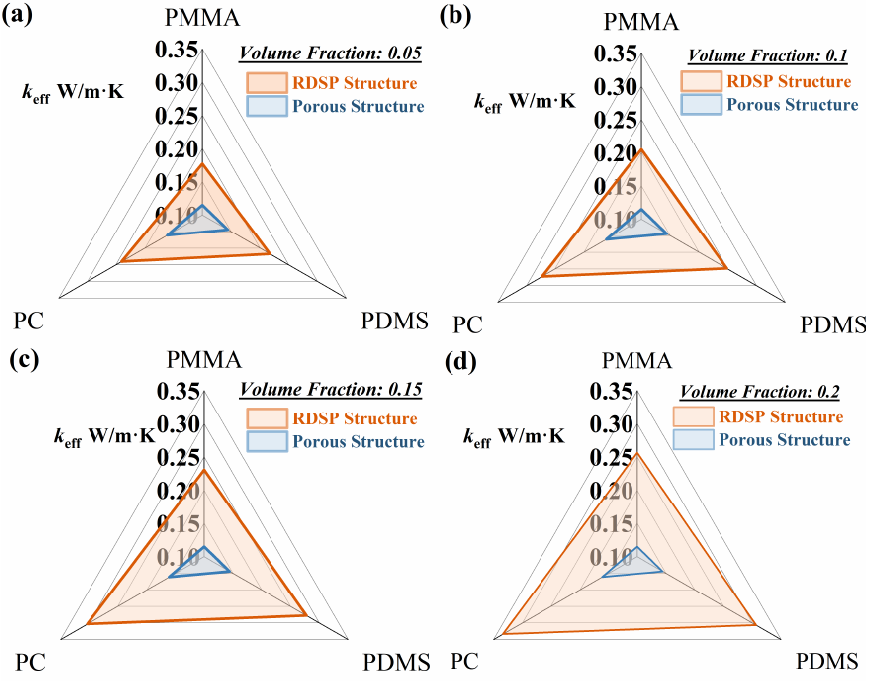
Figure 7. Thermal conductivity of radiative cooling film for different structures: ( a ) f v = 0.05, ( b ) f v = 0.1, ( c ) f v = 0.15, and ( d ) f v =